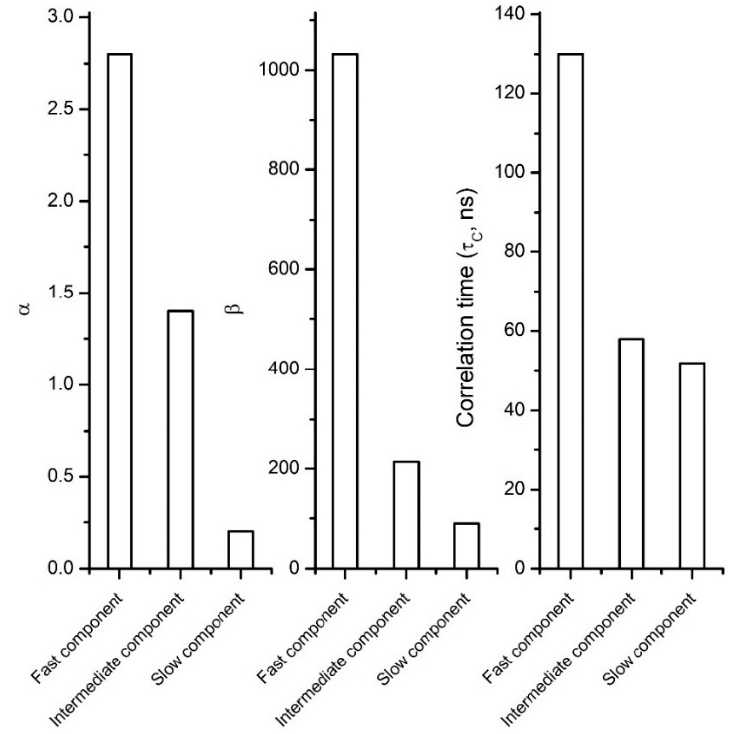
Figure 10. Values of α , β , and τ C for the three components of the water motion in quartz sand. These parameters were obtained by fitting the NMRD profiles in Figure 9 by the BPP model given in Equation (9).